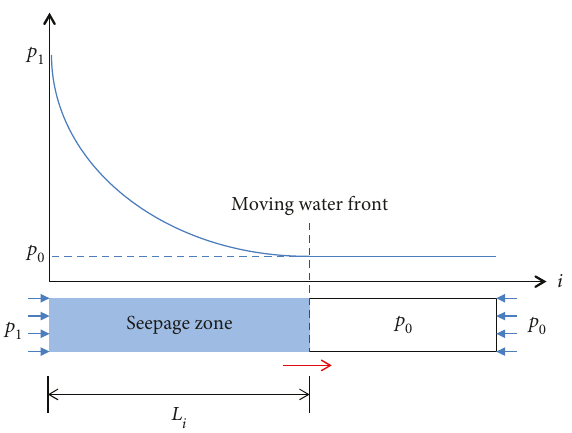
Figure 1: 1D seepage-controlled model with moving water